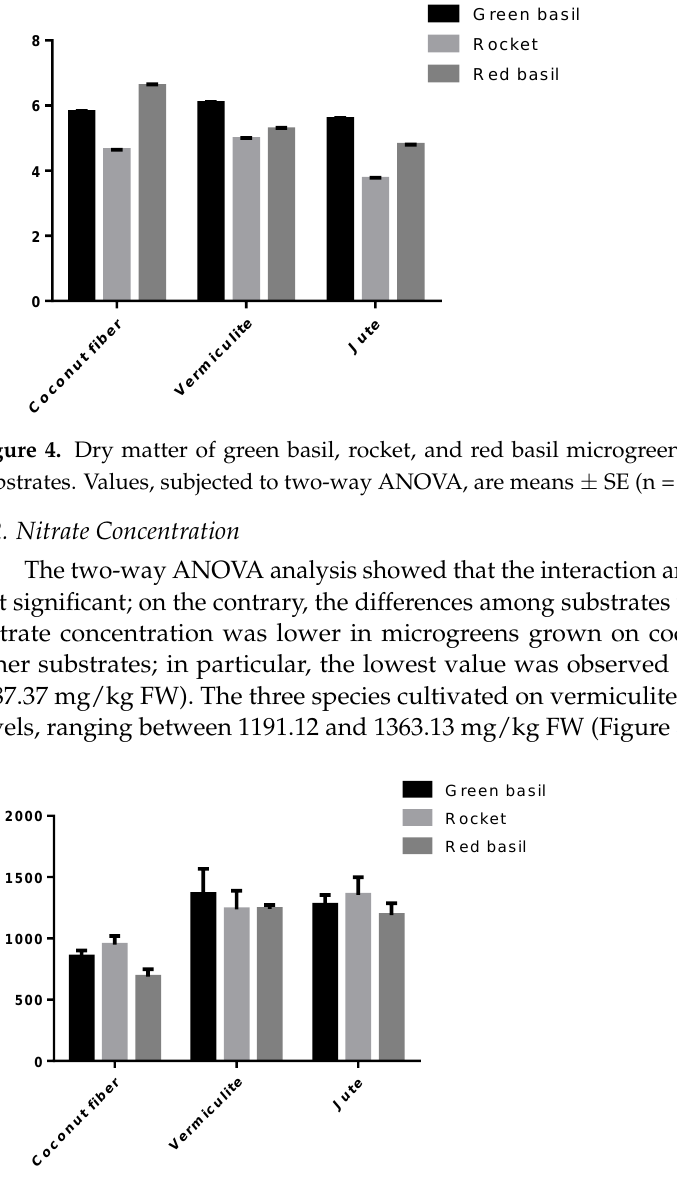
Figure 3. Yield of green basil, rocket, and red basil microgreens grown on three different sub- strates (coconut fiber, vermiculite, and jute). Values, subjected to two-way ANOVA, are means ± SE (n = 6).